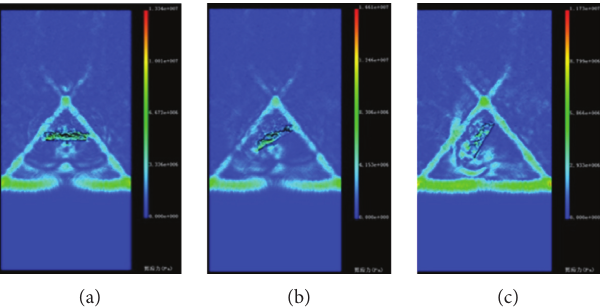
Figure 12: Failure process of rock specimen with different preexisting crack inclination angle when subjected to stress wave I. (a) α � 0 ° . (b) α � 30 ° . (c) α � 60 °